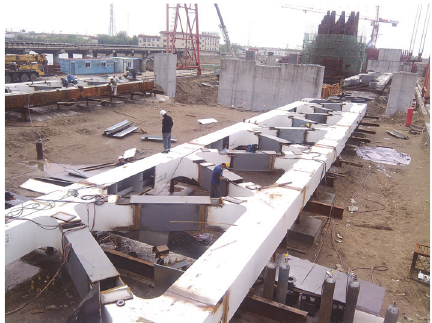
Figure 1: Steel truss girders in the bridge.